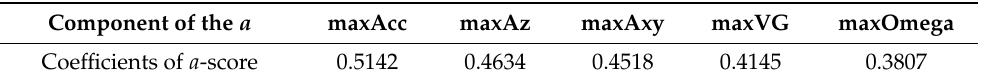
Table 2. Coefficients of the a -score in relation to the component of the a -vector. Details of the parameters used are in Section 2.3.